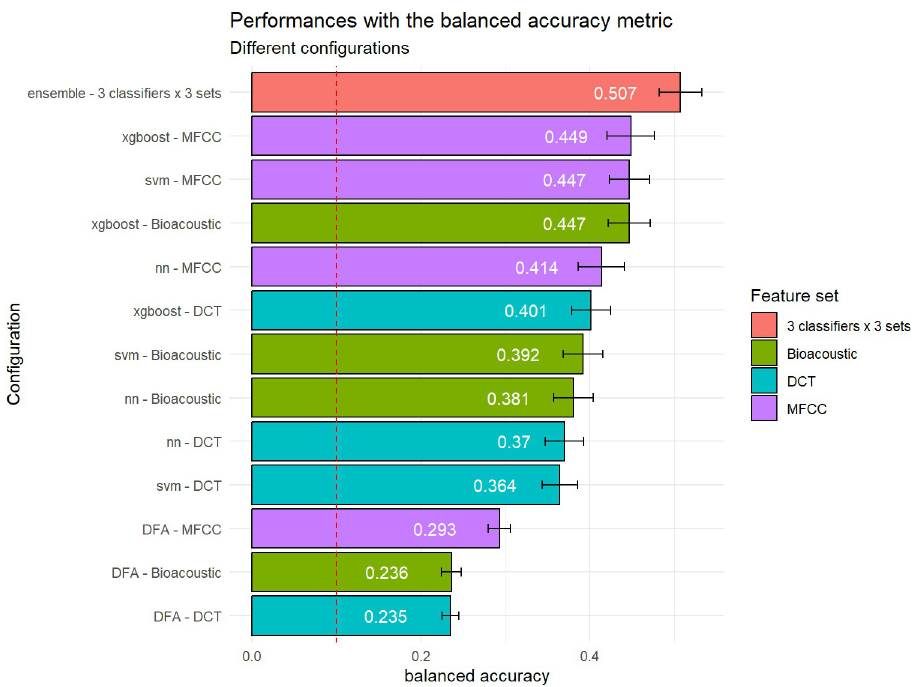
Fig 9. Performance in classifying bonobo individual signatures as a function of classifier and acoustic set used. The red bar shows the performance achieved by an ensemble classifier combining the 9 primary classifiers. The other bars correspond to configurations associating each classifier with different sets of acoustic features (Bioacoustic, DCT, MFCC). The configurations are sorted by decreasing performance from top to bottom. Performance is reported in terms of balanced accuracy. Green, turquoise, and purple indicate the models trained on the Bioacoustic, DCT, and MFCC feature sets respectively. Chance level is represented by the vertical dashed red line. The error bars report the standard deviation of the performances for the 100 iterations of the evaluation